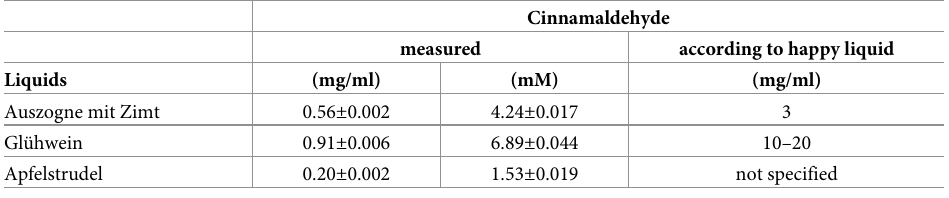
Table 3. Cinnamaldehyde content in